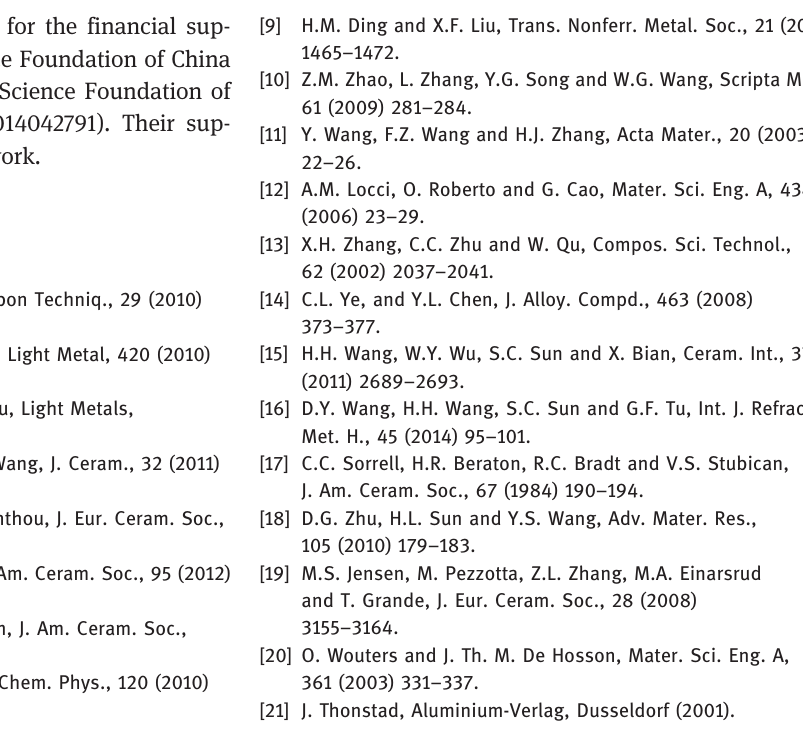
Figure 6: SEM micrographs of fracture surface for (a) pristine TiB 2/ TiC composites, TiB 2/ TiC exposed in (b) Nd and (c) molten NdF 3 – LiF – Nd 2 O 3